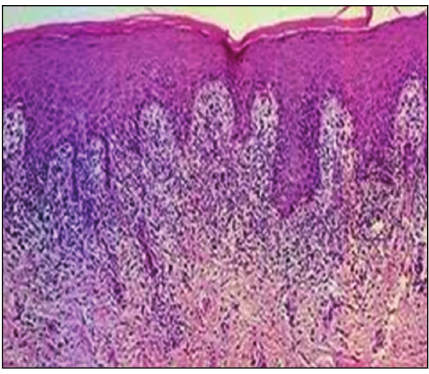
Figure 2: Photomicrograph (5x magnification) of the lesion.